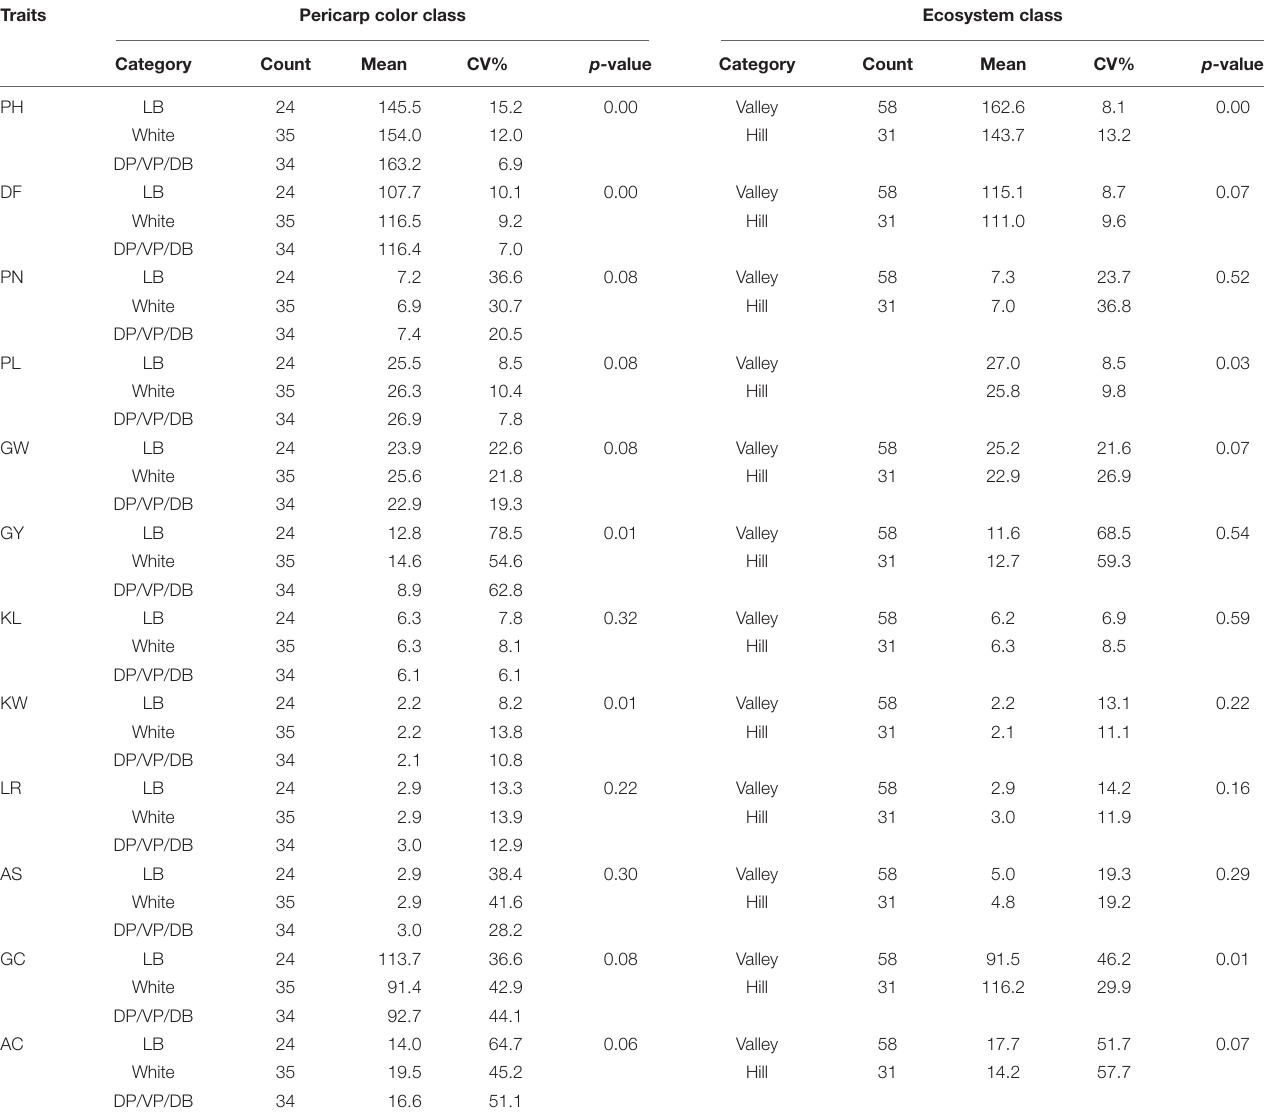
TABLE 2 | Analysis of variance for different agro-morphological and grain quality traits in the aromatic rice germplasm of Manipur over a priori classification based on pericarp color and ecosystem adaptation. Traits Pericarp color class Ecosystem class